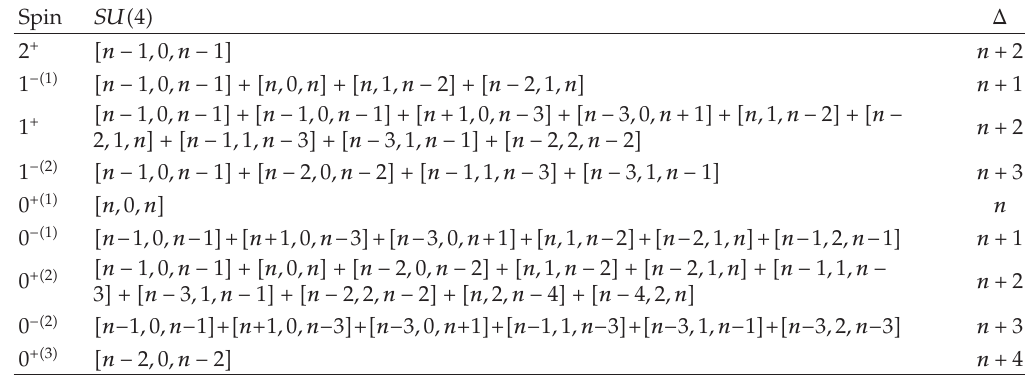
Table 3: Bosonic KK spectrum of the SW theory at level m (cid:8) 2 n , with n ≥ 1. The states with negative Dynkin labels should be excluded. In the case n (cid:8) 1 some of the fields are absent, reflecting the fact that the original S 7 multiplet is shorter.